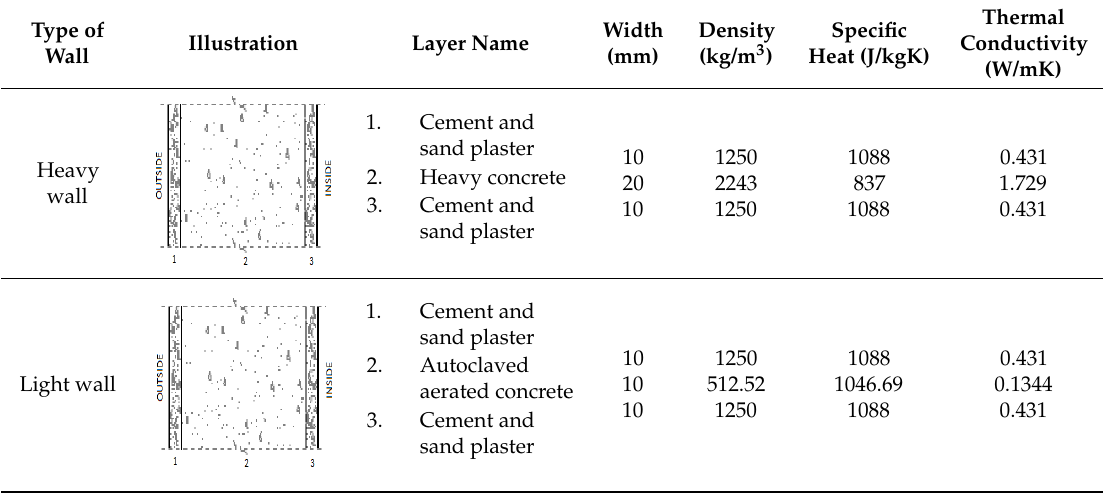
Table 19. Thermal properties of the alternate walls.